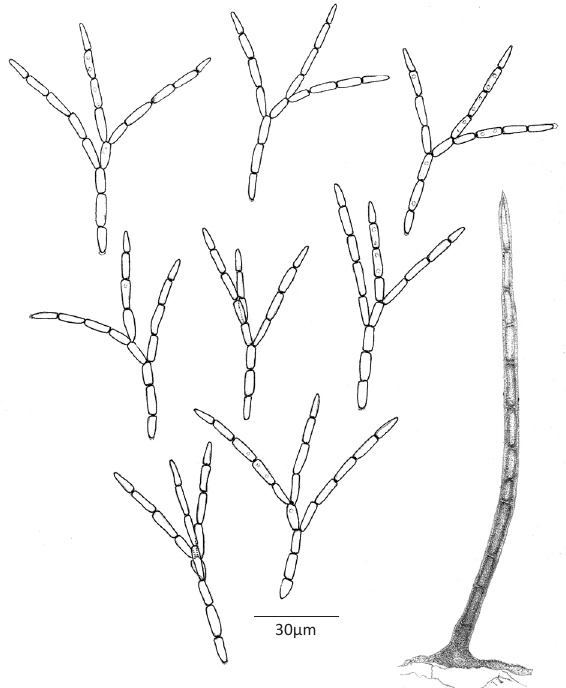
Figure 1. Phalangispora bharathensis, AMH 9580. A ‐ Variation in conidial shape; B ‐ Setae.